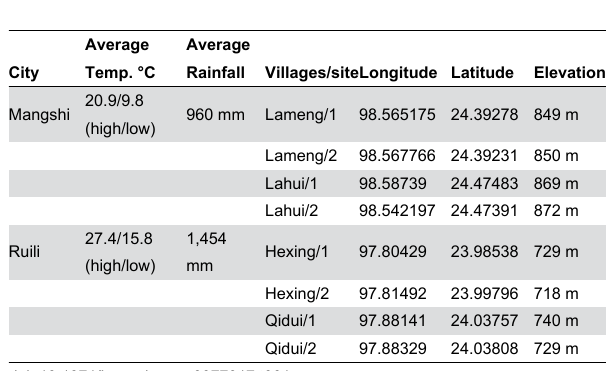
Table 1. Geographic location and elevation of villages where mosquito collections occurred from Jan-Dec